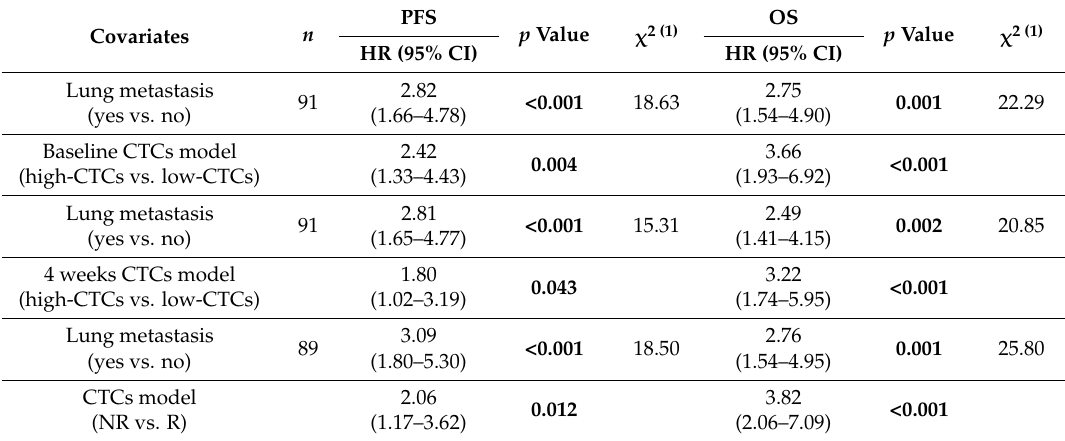
Table 3. Multivariate Cox regression analysis for progression-free survival (PFS) and overall survival (OS) of patients’ clinical characteristics at baseline, and the four-week follow-up PrediCTC multimarker model.